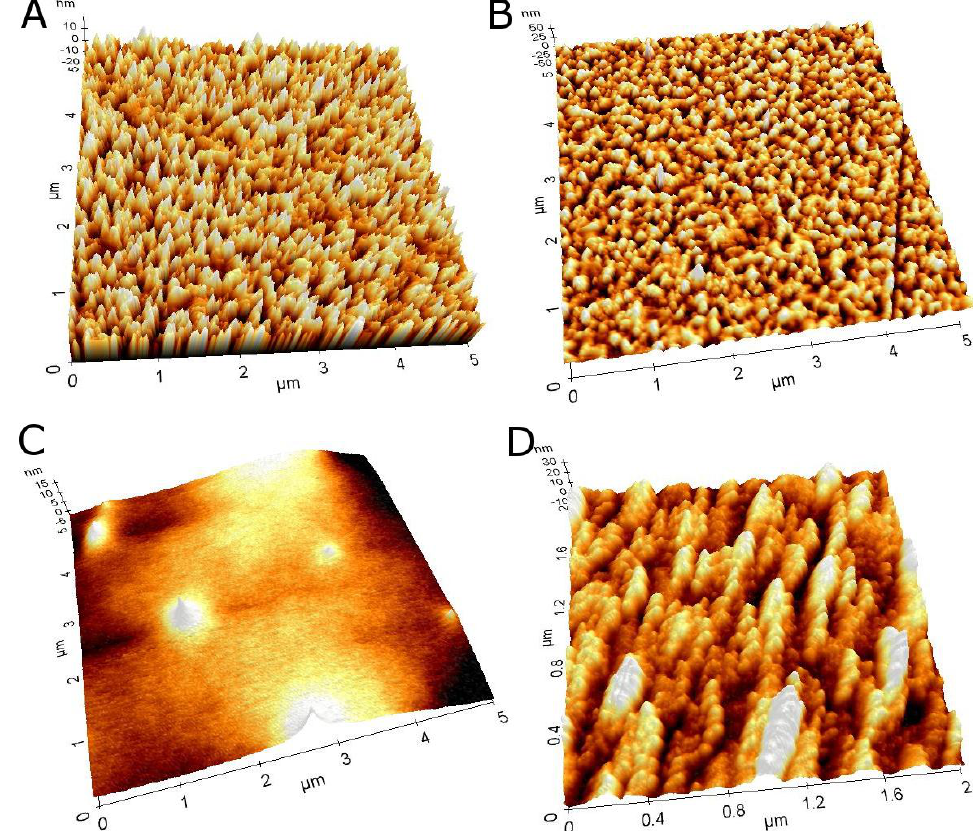
Figure 3. Atomic force microscope images of 5 × 5 µm (2 × 2 µm for CYP3A4 layer) areas of ( A ) Au, ( B ) Au/MPS, ( C ) Au/MPS/PAMAM G4.0-Au and ( D ) Au/MPS/PAMAM G4.0-Au/CYP3A4 respectively. No significant difference can be seen between ( A ) and ( B ) which can be explained